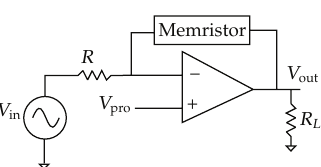
Figure 5: Simplified schematic diagram of the memristive synaptic